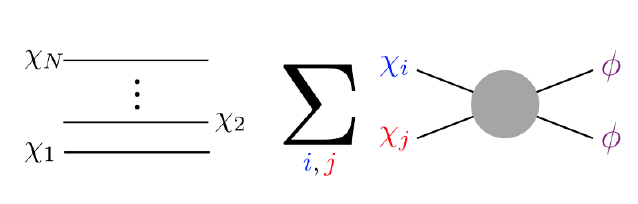
Figure 1 . Illustration of the collection of N states, (cid:31) i , required to realize coannihilation ( left ) and the processes that control DM freeze-out ( right ). DM annihilates into unstable states, (cid:30) , from the thermal bath. The N states share a quantum number and eventually decay to the lightest state, (cid:31) 1 , which constitutes the DM today. Freeze-out is determined by a summation over all possible annihilation modes among the collection of